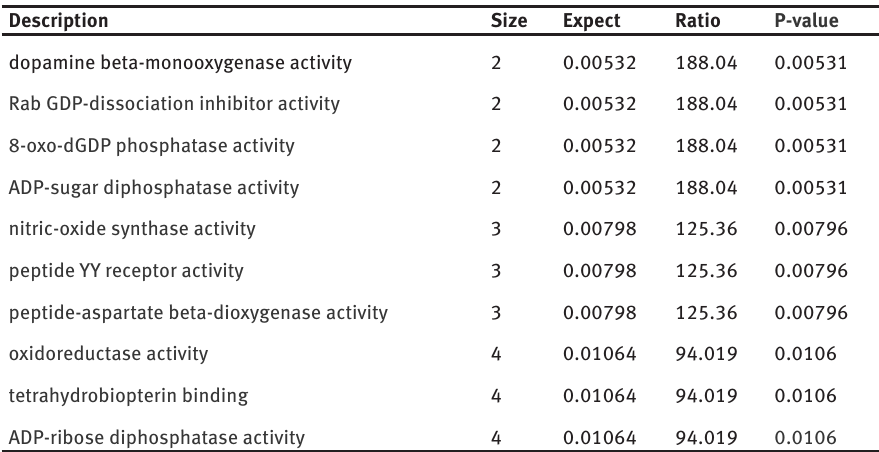
Table 3: Molecular function enrichment for iNOS/NOS2 and co-expressed